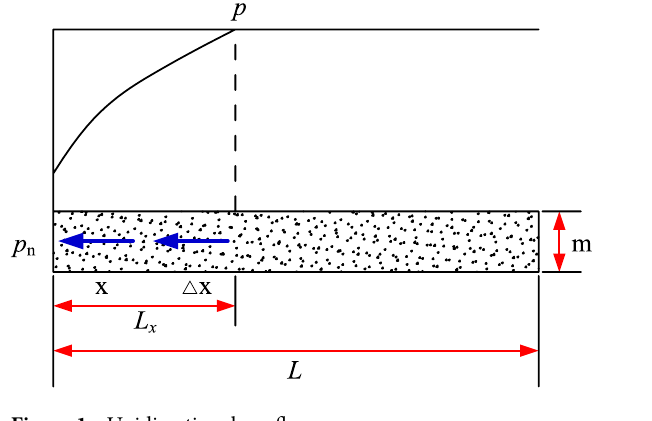
Figure 1. Unidirectional gas